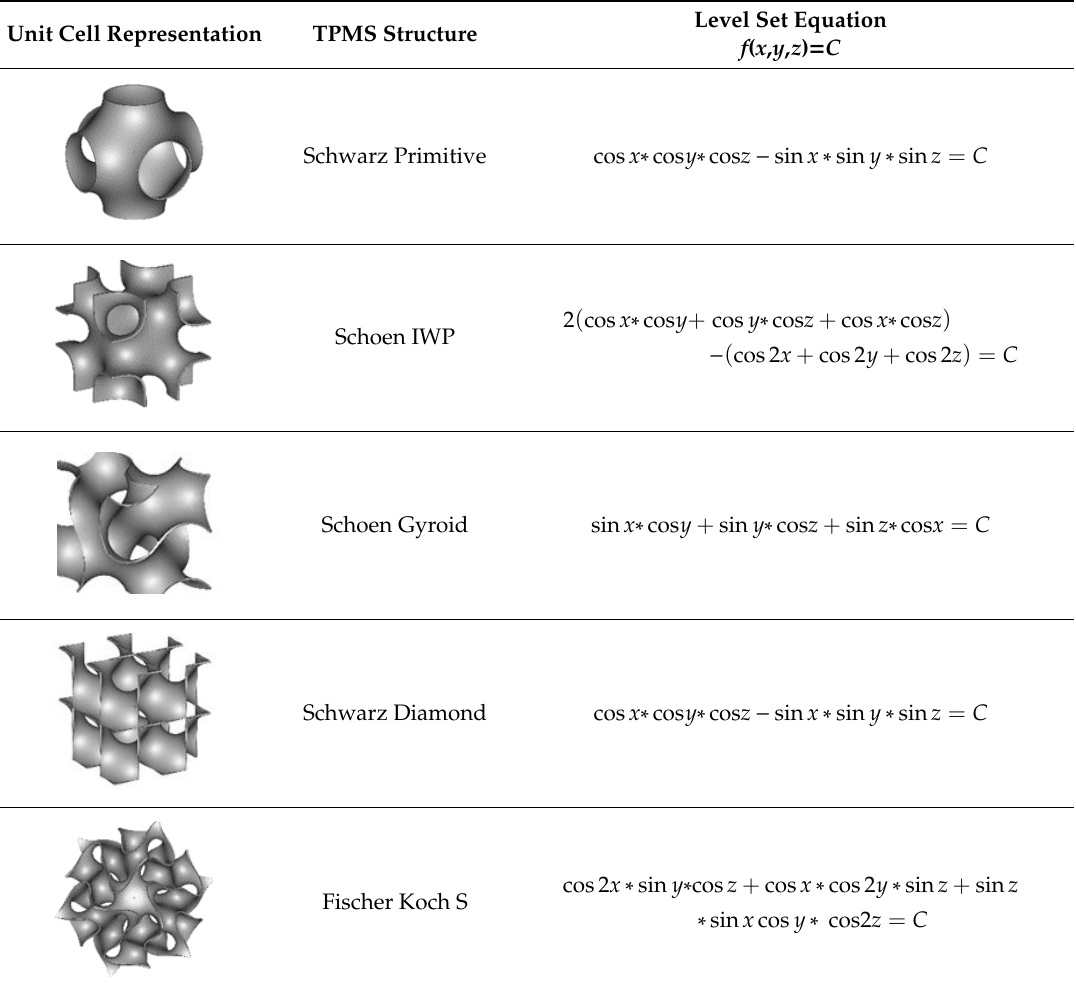
Table 1. Examples of triply periodical minimal surface (TPMS) unit cells [63].